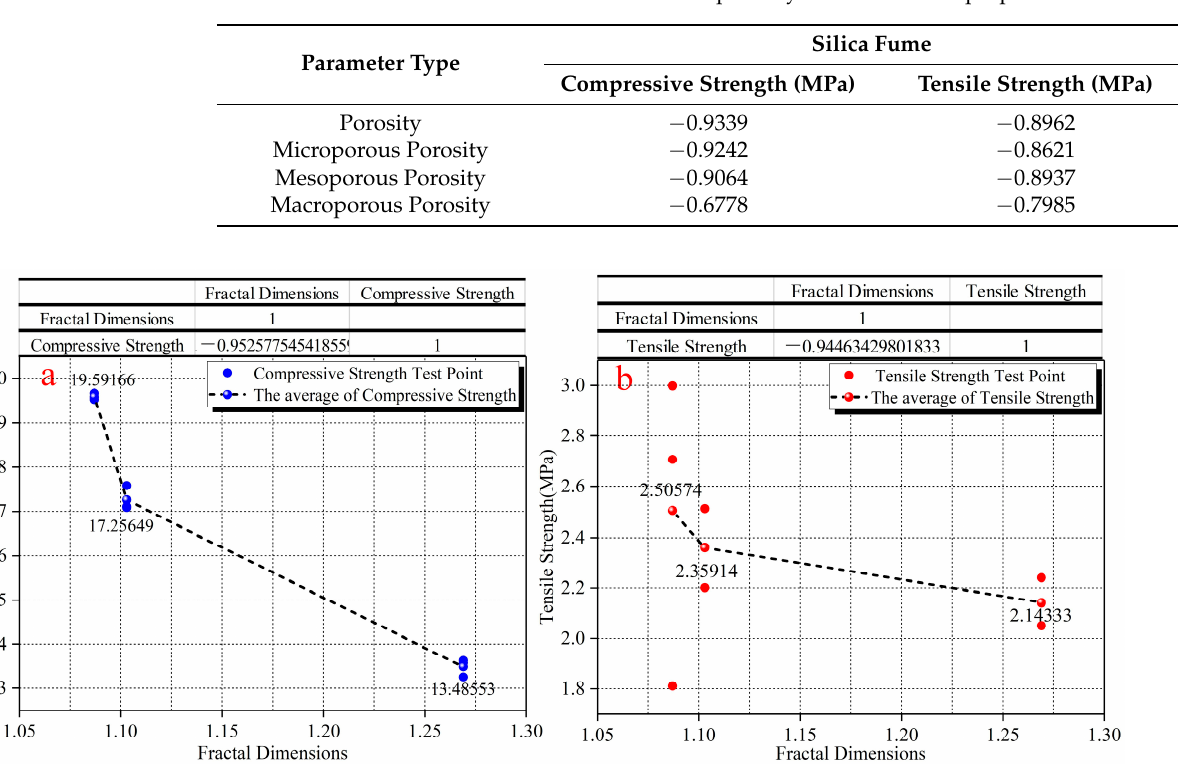
Table 7. Correlation coefficients between different porosity and mechanical properties.